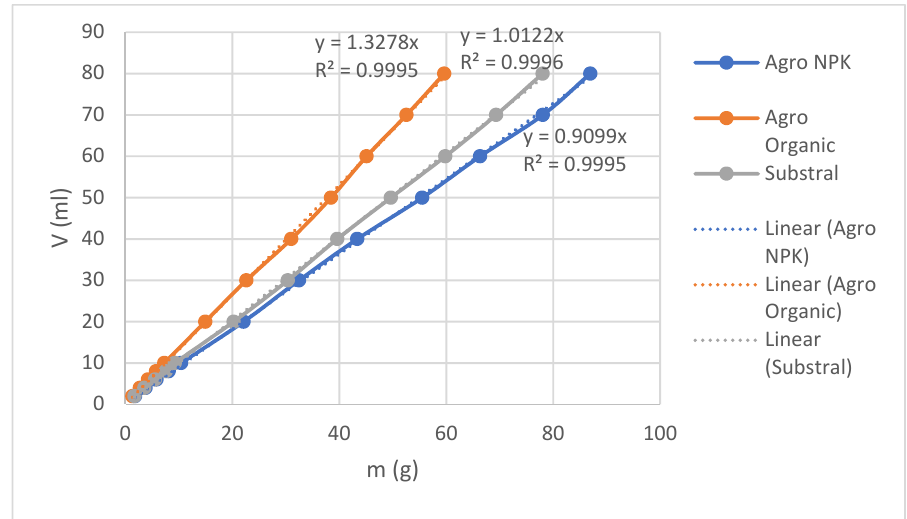
Figure 8. The mass-to-volume dependency of blueberry fertilizers.